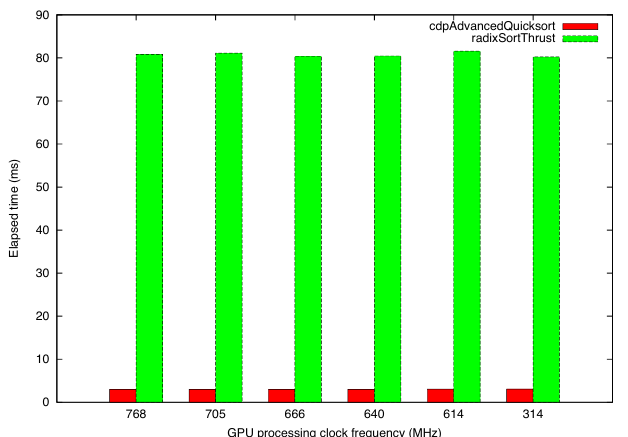
Figure 15. GPU processing elapsed time of cdpBezierTessellation